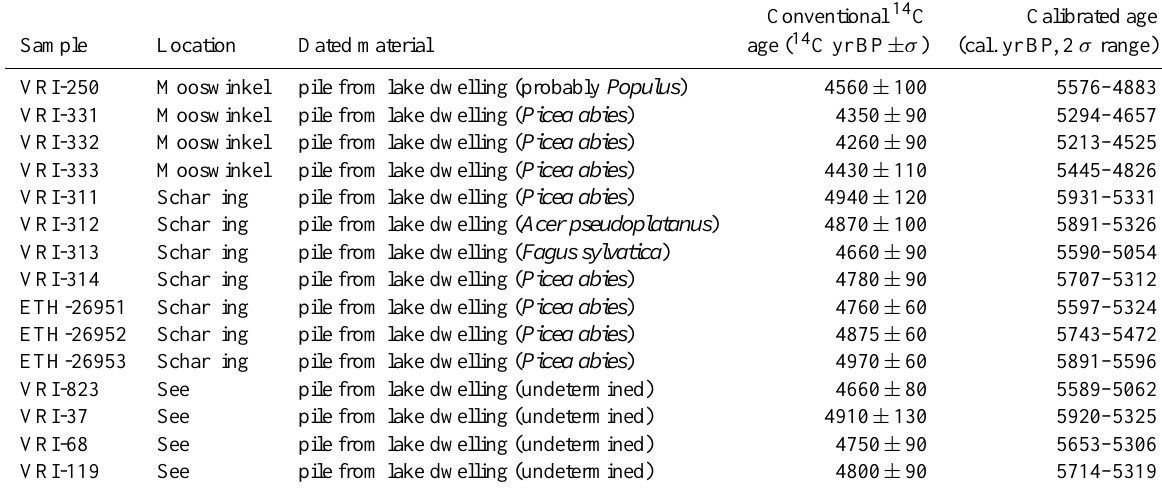
Table 1. Radiocarbon dates obtained from remnants of Neolithic lake dwellings in Lake Mondsee. Conventional 14 C ages (Felber and Pak, 1973; Felber, 1970, 1974, 1975, 1985; Dworsky and Reitmaier, 2004) were calibrated using OxCal 4.1 (Ramsey, 1995, 2001, 2009) with the IntCal09 calibration data set (Reimer et al.,